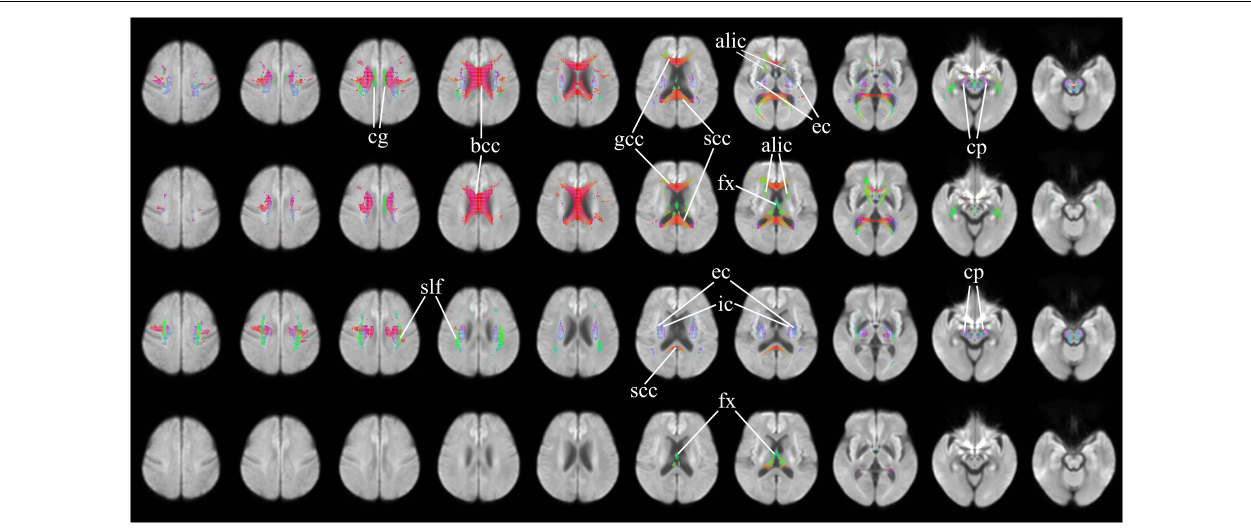
FIGURE 2 | Areas of significant differences in FDC, FD, and FC in patients with HD compared to healthy control participants, displayed in the axial view. Significant fixels (family-wise error corrected p < 0.05) are illustrated and colored according to fiber direction. Top row: FDC reductions in patients with HD compared to healthy controls; second row: FD reductions in patients with HD compared to healthy controls; third row: FC reductions in patients with HD compared to healthy controls, areas of higher FC in patients with HD compared to healthy controls; bottom row: areas of higher FC in patients with HD compared to healthy controls. cg, cingulum; bcc, body of corpus callosum (corona radiata white matter fibers); gcc, genu of corpus callosum (forceps minor fibers); scc, splenium of corpus callosum (forceps major fibers); alic, anterior limb of internal capsule (anterior thalamic radiation and frontopontine fibers); ec, external capsule (claustrocortical fibers, uncinate fasciculus, and inferior frontal occipital fasciculus); cp, cerebral peduncles (extrapyramidal tracts); fx, fornix (pre- and post-commissural fibers); slf, superior longitudinal fasciculus; ic, internal capsule (white matter projection fibers of the corona radiata).